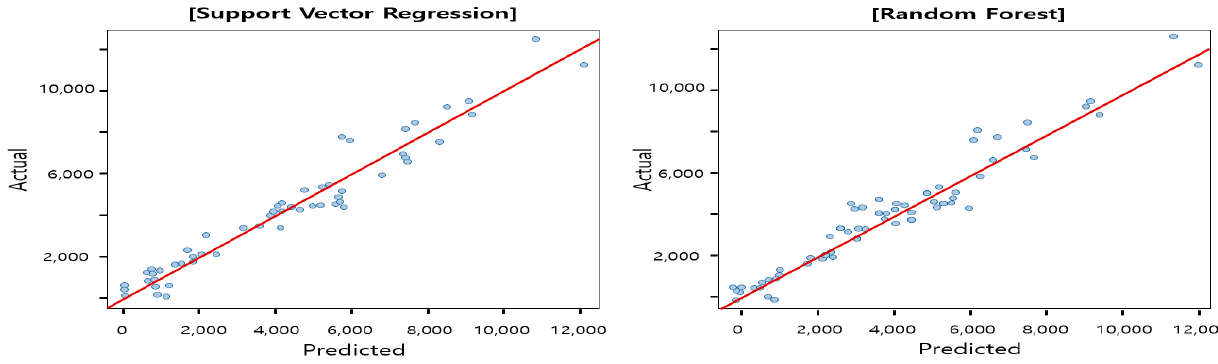
Figure 9. Comparison of T/C option prices (L: SVR, R: RF).